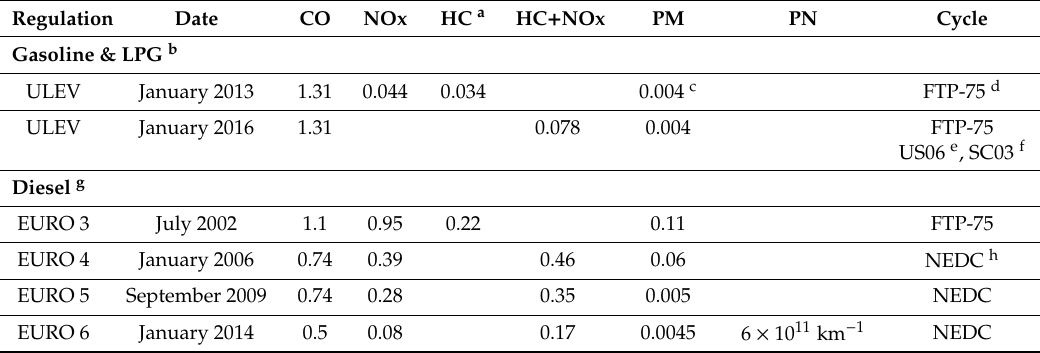
Table 1. Emission standards in Korea(unit: g km − 1